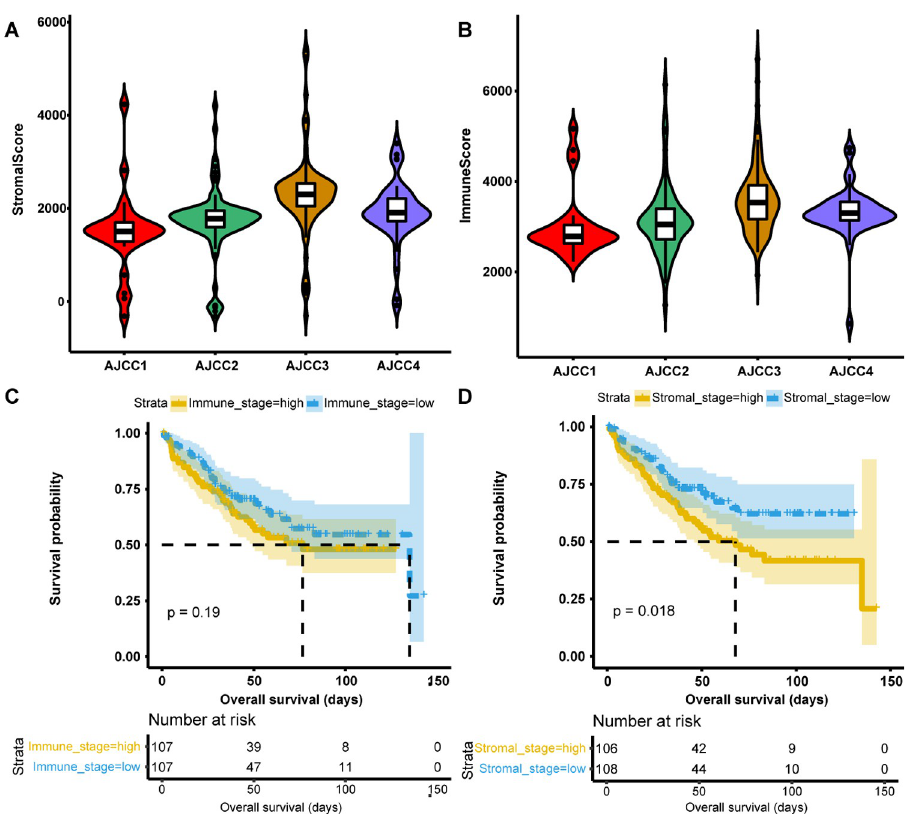
Fig 1. Results of correlation analysis. (A) Association between stromal score and CRC AJCC stage. (B) Association between the immune score and CRC AJCC stage. (C) Correlation between the stromal score group and the survival time of patients with CRC. (D) Correlation between the immune score group and the survival time of patients with